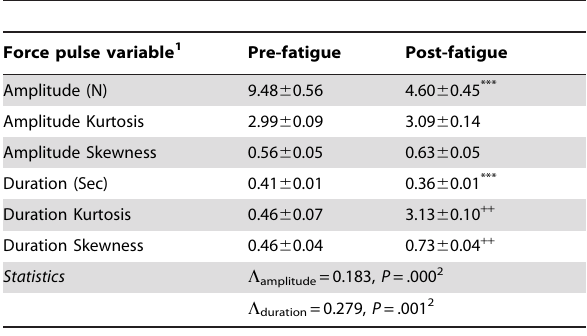
Table 2. Hotelling’s T 2 statistics for force pulse variables in the pre-fatigue and post-fatigue tests.